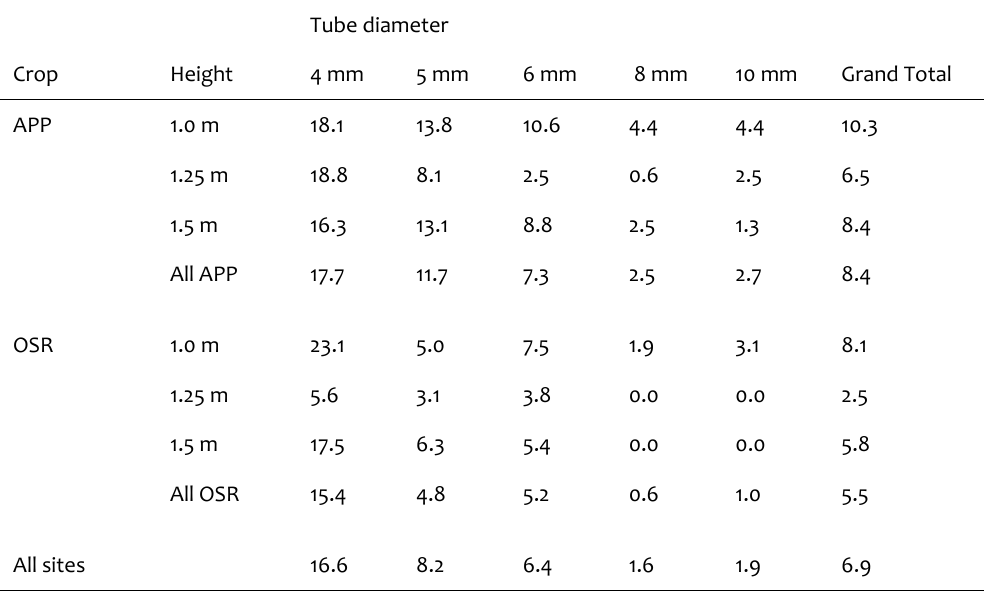
Table 1. Proportion (%) of sealed cardboard nest tubes set at three heights at eight apple (APP) and eight oil seed rape (OSR) sites in Ireland from March to September 2019. There were 20 tubes of each diameter at each height at each site (4800 tubes in